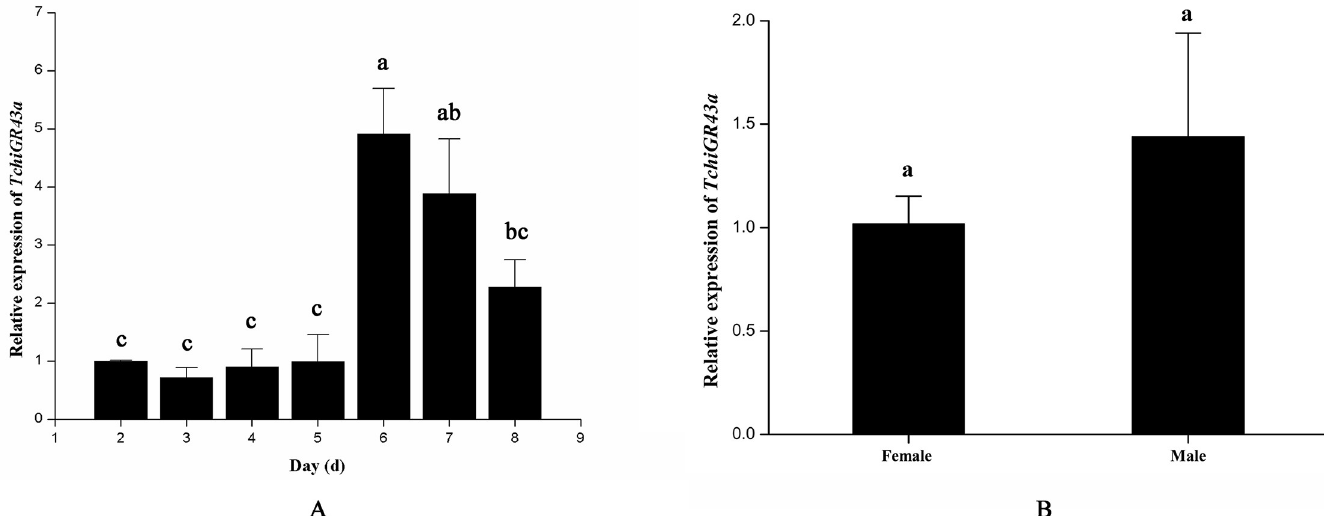
Fig 4. Expression patterns of TchiGR43a in T . chilonis . (A) Relative expression levels of TchiGR43a in different developmental stages of T . chilonis by qRT-PCR analysis. Larval stage: d2, prepupal stage: d3-d4, pupal stage: d5-d8. (B) Relative expression levels of TchiGR43a between male and female adult T . chilonis by qRT-PCR analysis. Error bars indicate SEMs from the analysis of three replications (P <